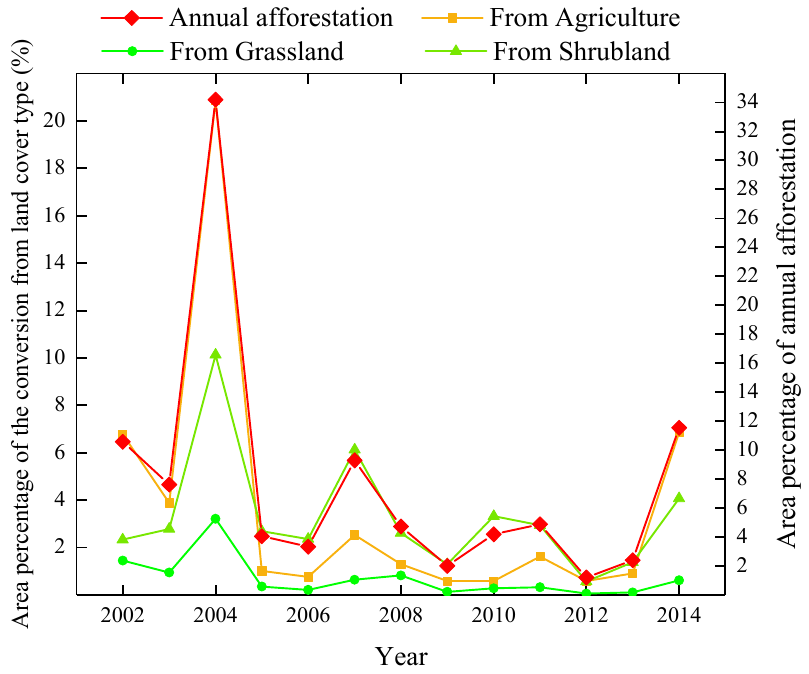
Figure 10. Original land cover types converted into forest and their area percentage in relation to the total afforestation area from 2001 to 2015.